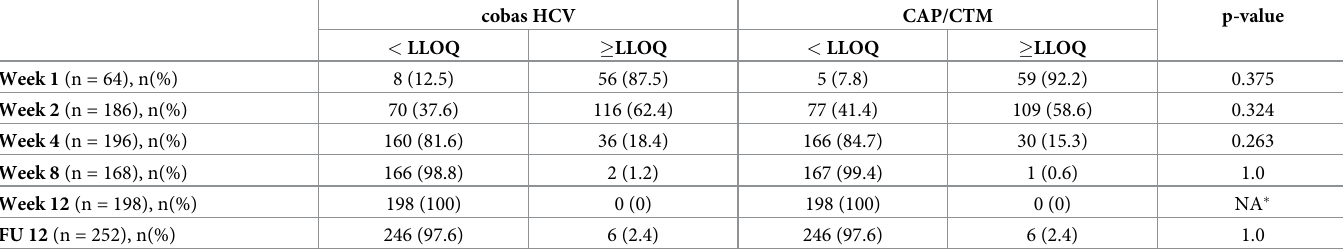
Table 2. Comparison of virologic responses at week 1,2,4,8,12, and at 12 weeks after the end of treatment (FU12) according to cobas HCV and CAP/CTM, respectively. cobas